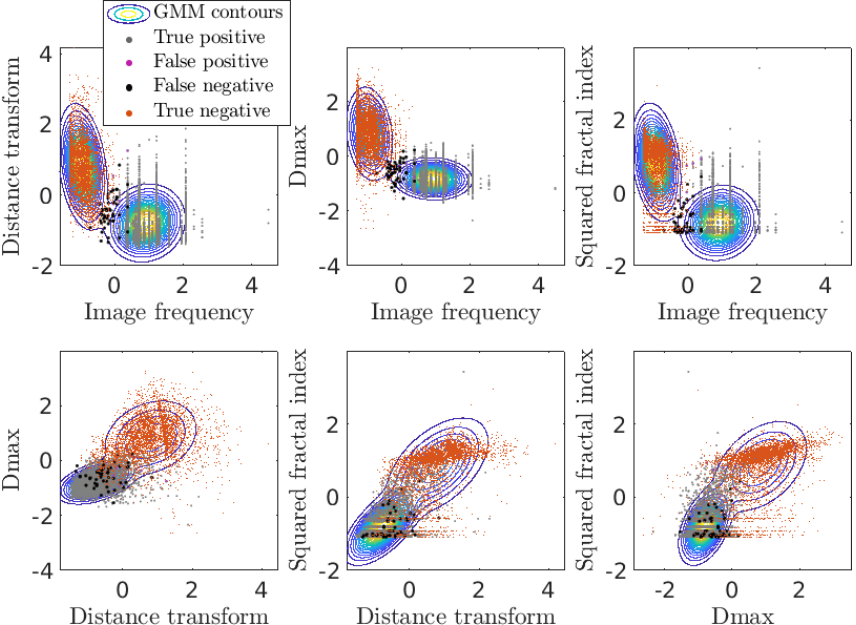
Figure 7. GMM contours and data points projected on the 2-D planes. The colors correspond to the four entries of the confusion matrix. The predictions result from the clustering and the ground truth is the given